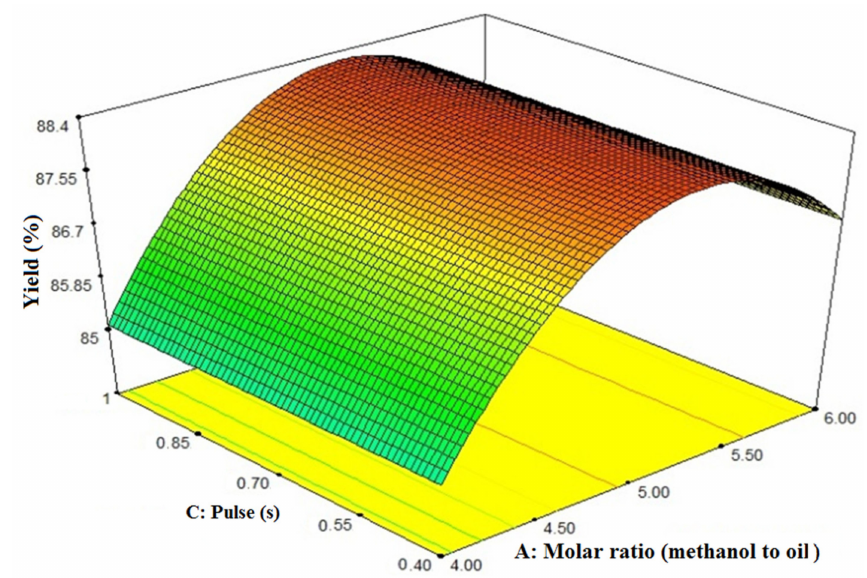
Figure 4. E ff ect of pulse on yield (methyl ester content) at the reaction time of 5.22 min.